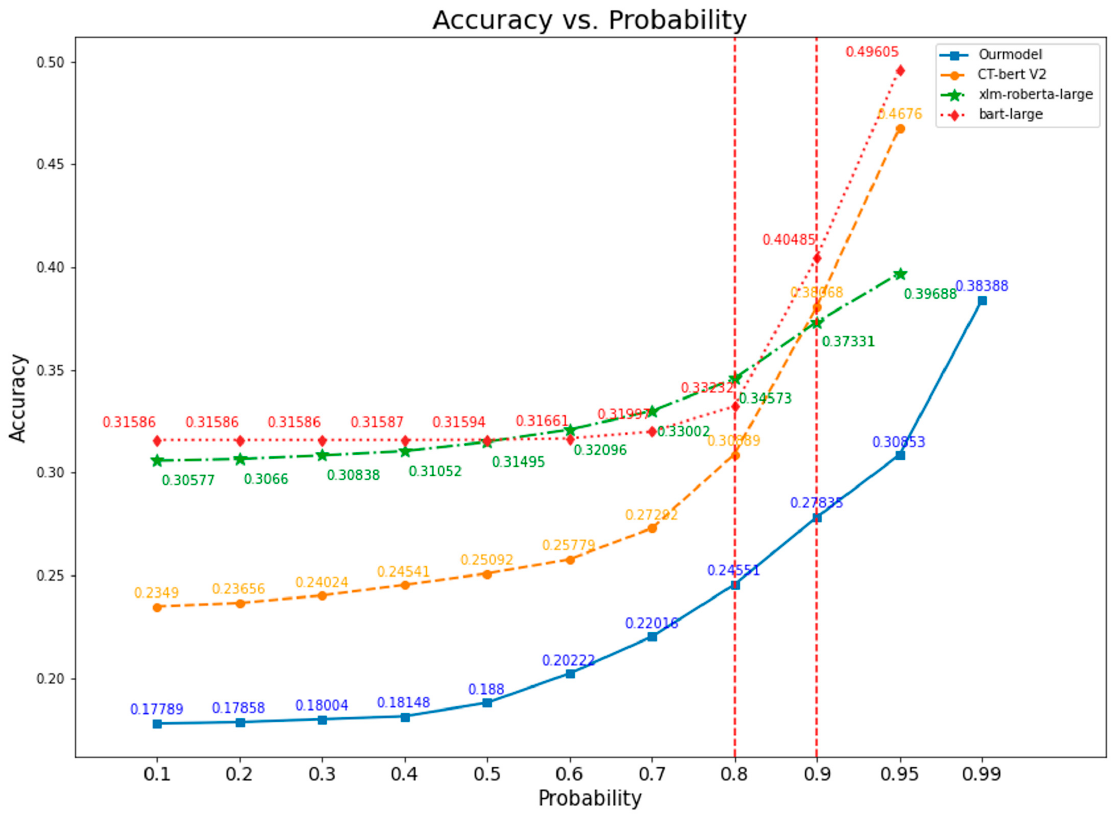
Figure 9. Accuracy vs. Probability comparison graph for all models